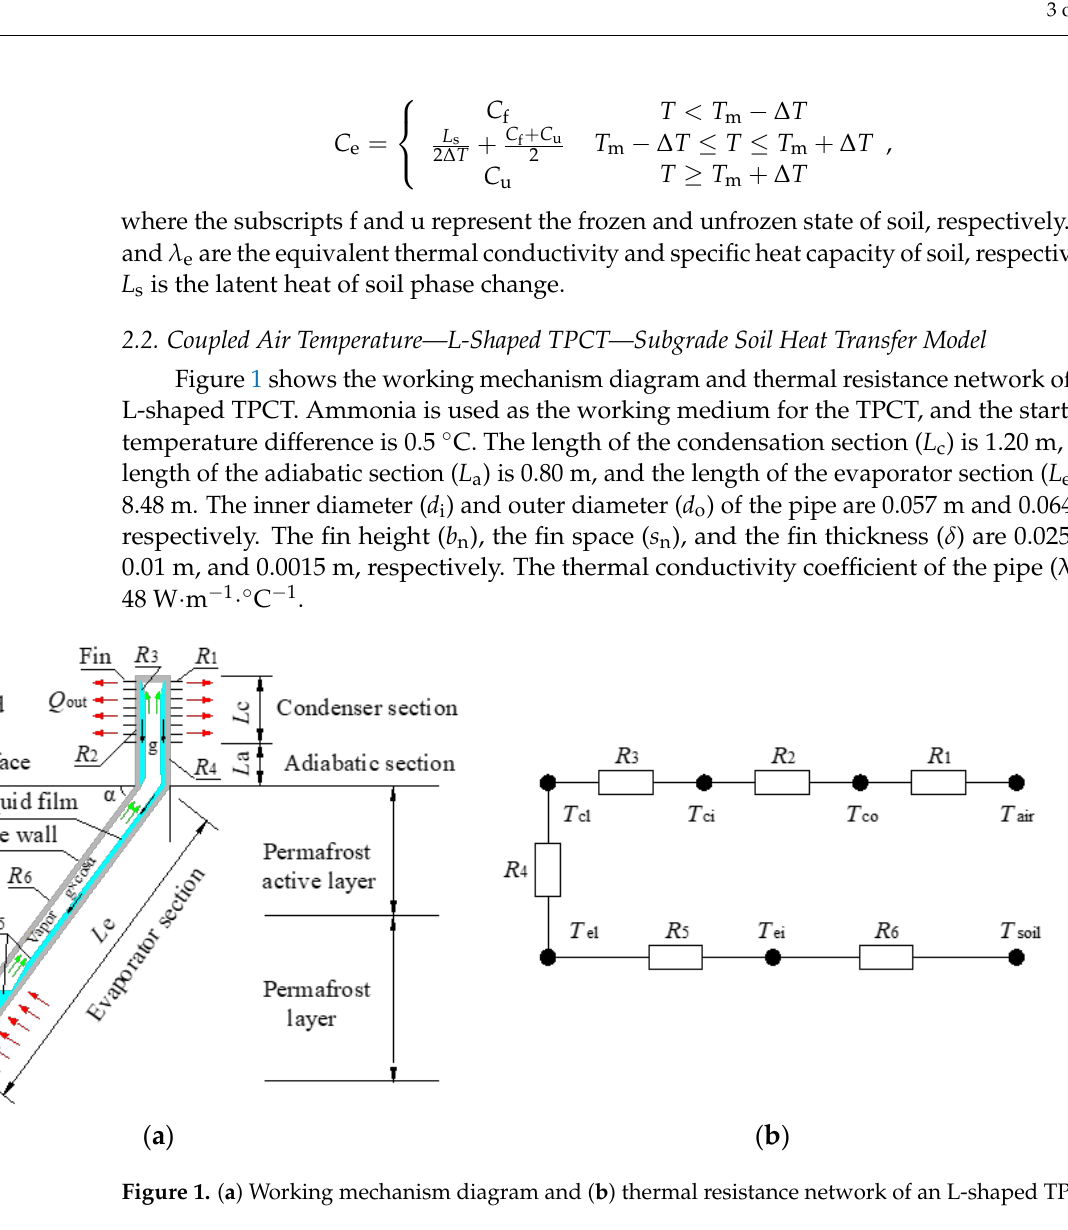
shows the physical parameters of the working medium of the TPCT [28,29]. n is the number of fins, and r 1 and r 2 are the outer diameters of the smooth pipe and fins, respectively. area of the condenser section with fins, and A c3 is the total superficial area of the smooth condenser section. d co and d ci are the outer diameter and inner diameter of the condenser section, whereas d eo and d ei are the outer diameter and inner diameter of the